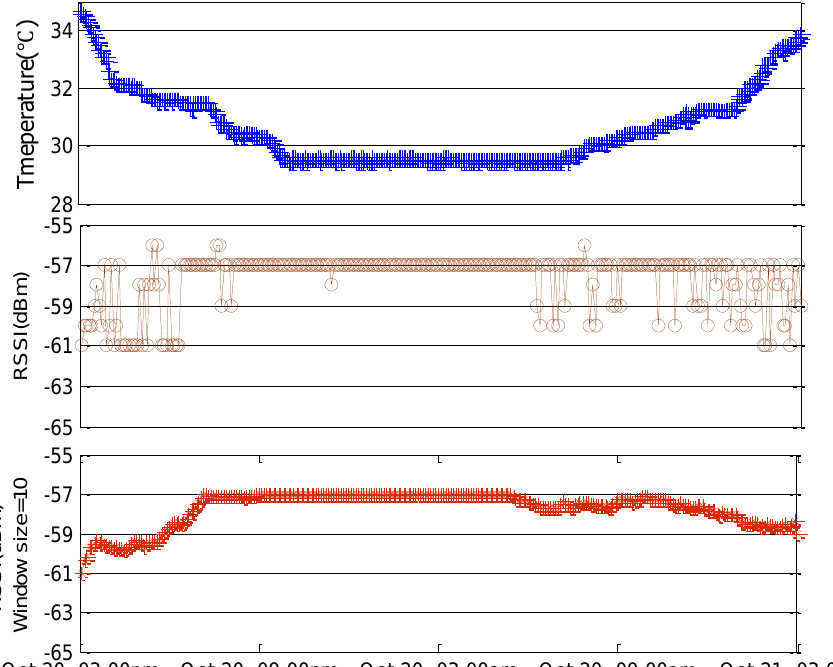
Figure 2. The change of RSSI according to